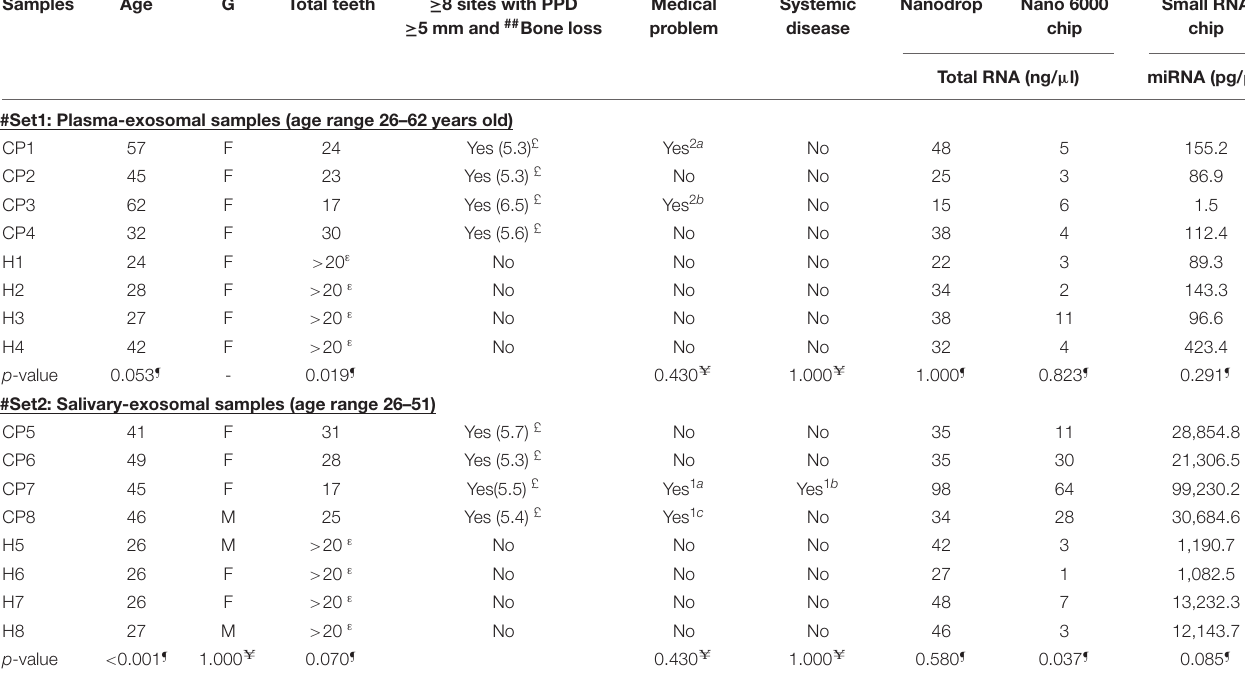
TABLE 1 | Characteristics of recruited individuals and their samples’ total RNA and miRNAs concentration. Samples ≥ 8 sites with PPD ≥ 5 mm and ## Bone